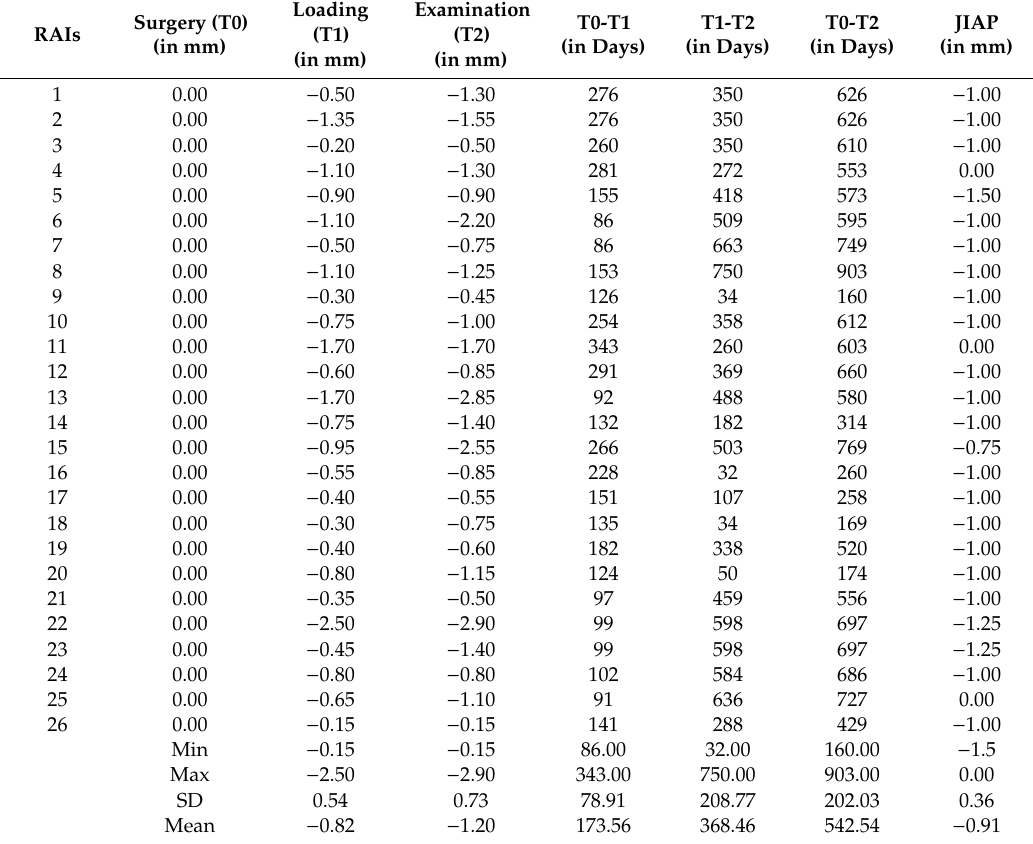
Table 5. Marginal bone loss and time di ff erence from surgery (T0) to loading (T1) and the follow-up examination